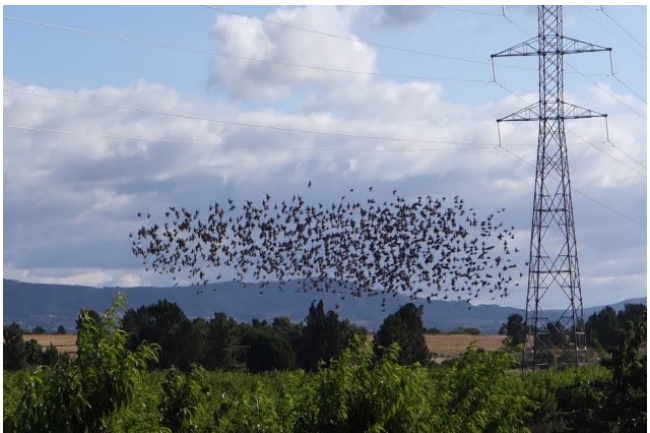
Figure 1. Flock of birds in Soalheira, Fundão, Portugal.